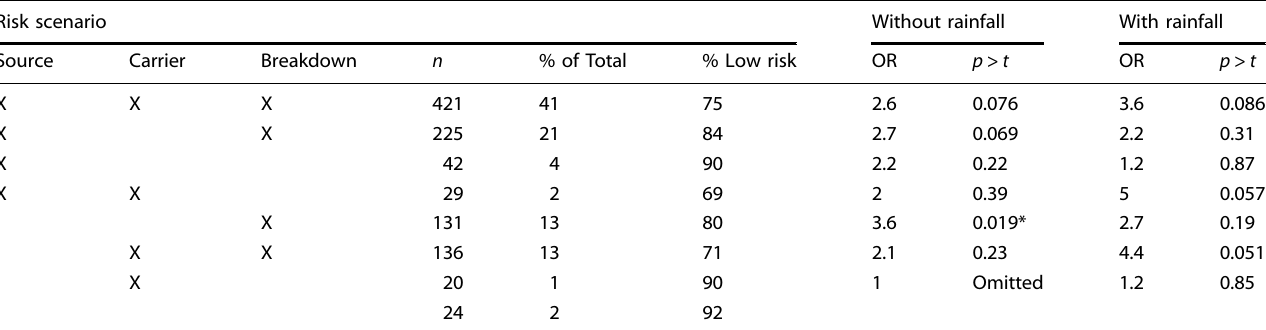
Table 3. Summary statistics describing possible risk scenarios, with logistic regression results for the alternative model both with and without rainfall, incorporated — risk scenarios with * are signi fi cantly associated with E. coli presence/absence at the 95% con fi dence